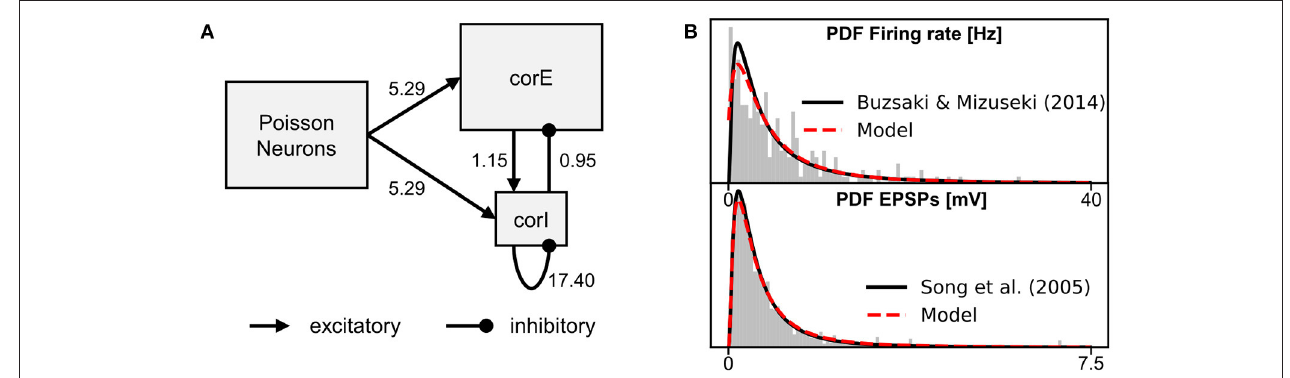
FIGURE 4 | Overview of the microcircuit model. (A) The structure of the microcircuit model. Rectangles represent the populations and arrows the projections. The numbers at the projections indicate the factors which scale the weights of each projection. (B) Probability density function (PDF) and histogram of the firing rate distribution of the neurons of the corE and corI populations (top) and PDF and histogram of the excitatory post-synaptic potentials (EPSPs) evoked by single spikes in the excitatory and inhibitory neurons (bottom). The weights for the projections of the microcircuit model were drawn from a weight distribution which was tuned to generate the EPSPs distribution of Song et al. (2005) (indicated in black). The weights of each projection were further scaled so that the corE and corI populations produce the firing rate distribution of Buzsáki and Mizuseki (2014) (indicated in black). The scaling factors were optimized, for more details see Supplementary Section 3.3